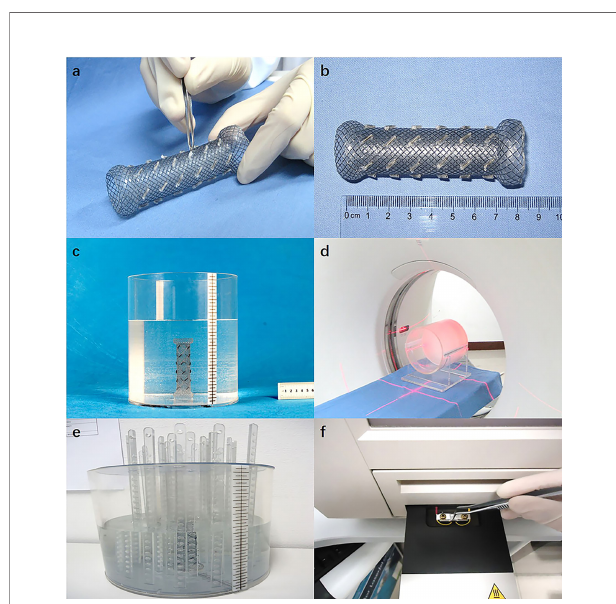
FIGURE 1 | (A) The periphery of the stent was bundled with a polyurethane catheter as the delivery sheath, which contains radioactive I-125 seeds; (B) The complete RIBS; (C) The RIBS was fi xed in a cylindrical phantom fi lled with paraf fi n melt; (D) CT scan (images were exported to the TPS); (E) After the RIBS was fi xed to the center of the cylindrical phantom and fi lled with distilled water, the TLD measuring rods were placed at different distances to the center of the stent; (F) TLD were read out 24 h after